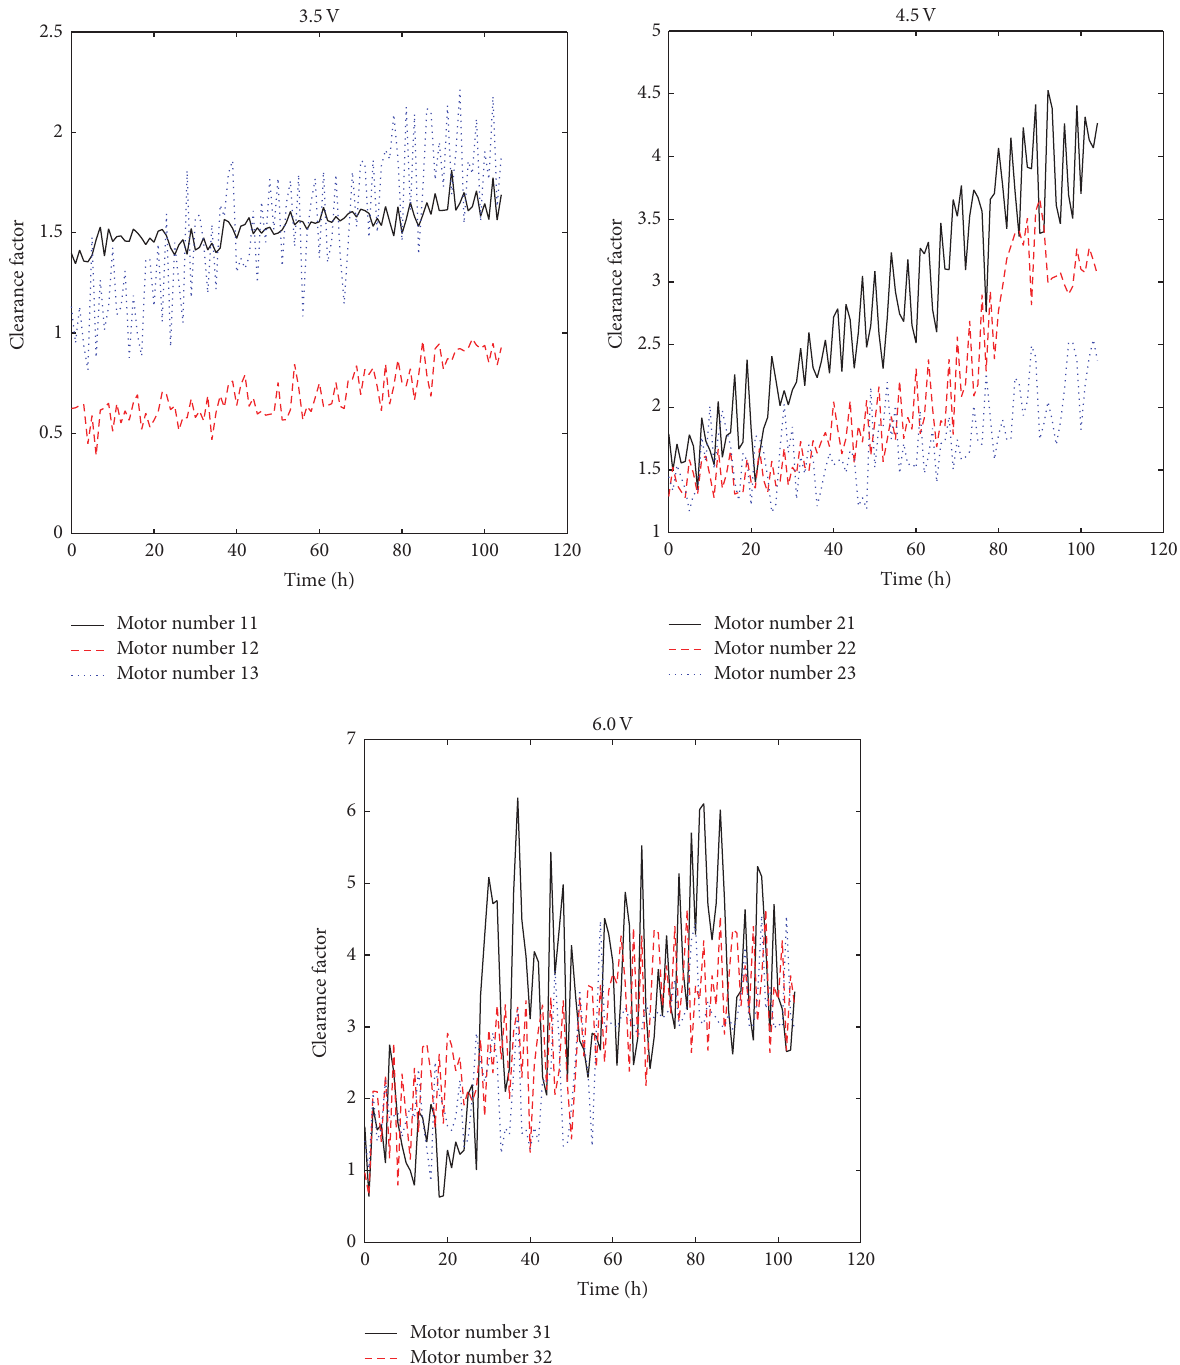
Figure 5: The CSADT data of clearance